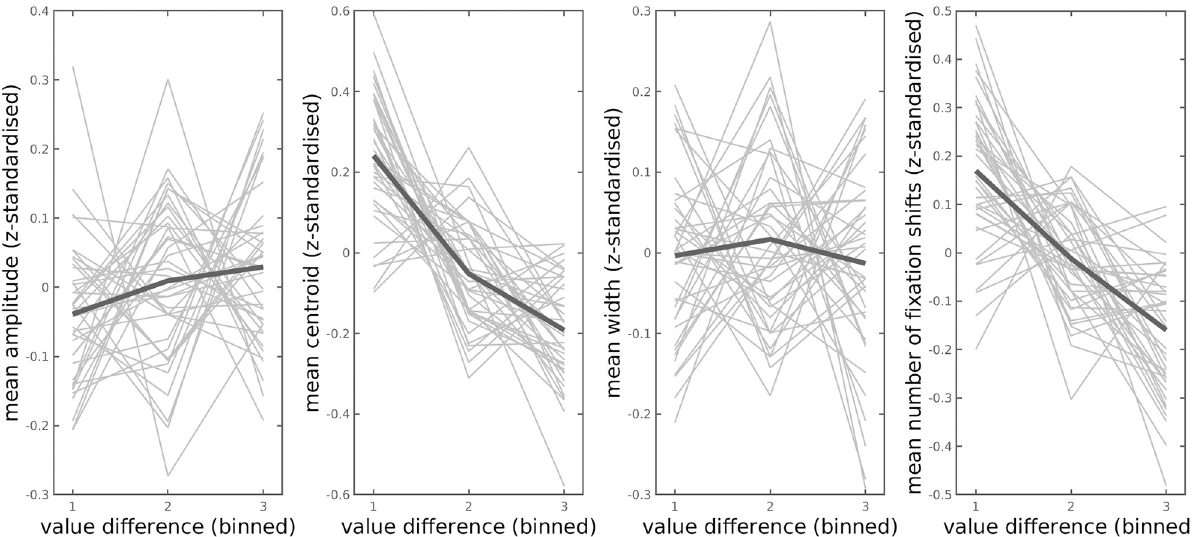
Fig 6. Mean amplitude and centroid of the Gaussian-modelled grip force response and mean number of fixation shifts (from SS to LL, and vice versa) for trials of a given value difference bin. The (absolute) value differences were z -standardised and binned participant-wise into 3 groups of equal size (based on quantile ranks of the values, 1: lower value differences, 3: higher value differences). Thick lines depict the mean values across participants.